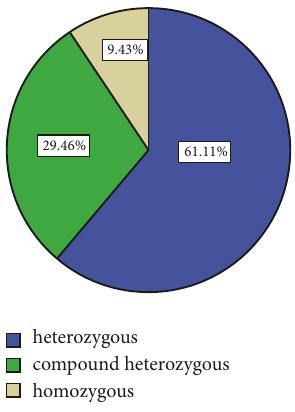
Figure 1: Distribution of MEFV alleles in the studied population.